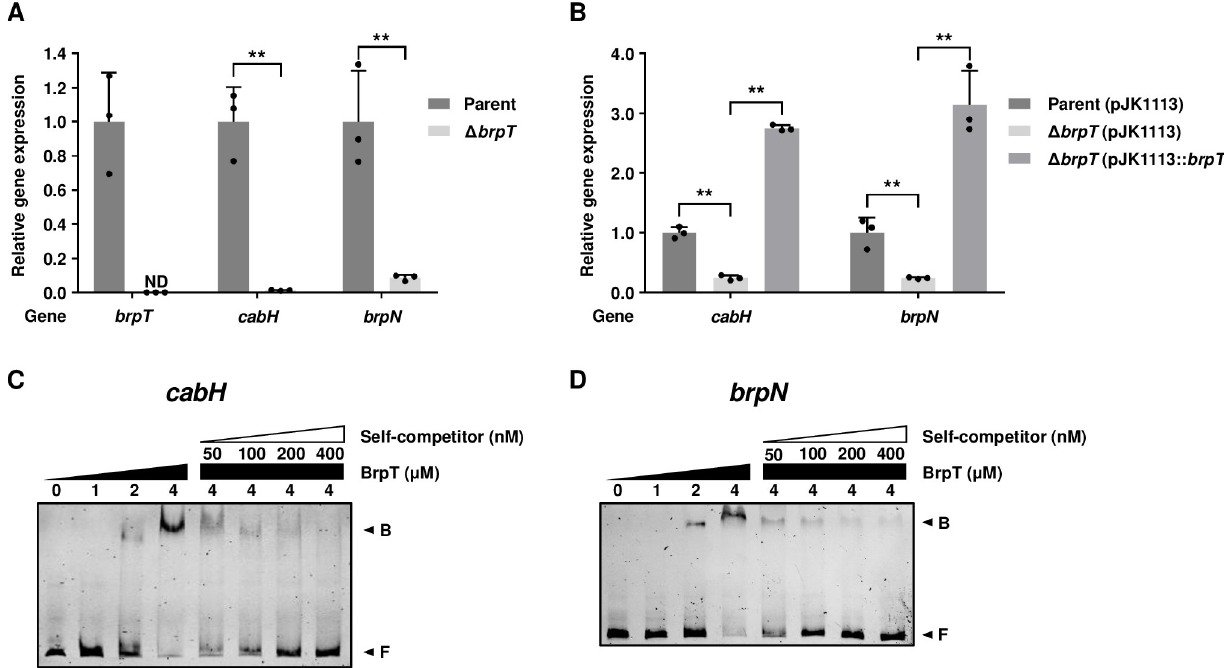
Fig 5. Direct regulation of the cabH and brpN expression by BrpT. (A, B) Effects of BrpT on the expression of cabH and brpN . Total RNAs were isolated from the V . vulnificus strains grown in LB supplemented with 0.01% (w/v) arabinose (A) or 0.03% arabinose, 100 μ g/ml kanamycin, and 100 μ g/ml ampicillin for complementation experiments (B). The expression of brpT , cabH , and brpN was determined by qRT-PCR analysis, and the expression of each gene in the parent strain was set as 1 ( n = 3). Error bars represent the SD. Statistical significance was determined by the Student’s t test ( �� , P < 0.005). ND, not detected. Parent and Parent (pJK1113), parent strain; Δ brpT and Δ brpT (pJK1113), brpT mutant; Δ brpT (pJK1113:: brpT ), complemented strain. (C, D) Direct binding of BrpT to upstream regions of cabH and brpN . The 6-FAM labeled DNA fragments (10 nM) of the upstream regions of cabH (C) and brpN (D) were incubated with increasing amounts of BrpT as indicated. For competition analysis, the same but unlabeled DNA fragments were used as self-competitors. Various amounts of self-competitors were added as indicated to the reaction mixtures before the addition of BrpT (4 μ M). Each gel representing the mean result from at least three independent experiments was photographed using ChemiDoc Touch Imaging System (Bio-Rad). B, bound DNA; F, free DNA.